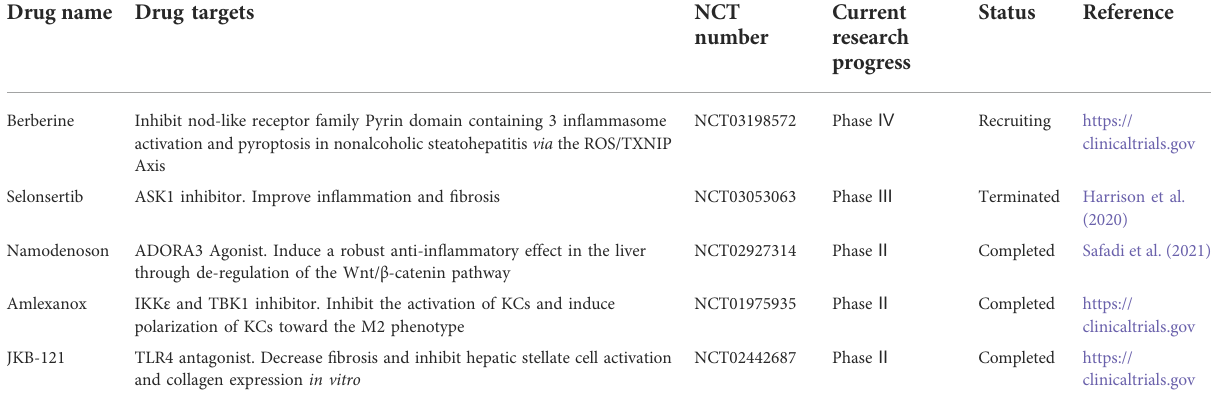
TABLE 3 Mechanism and Research Progress of drugs targeting in fl